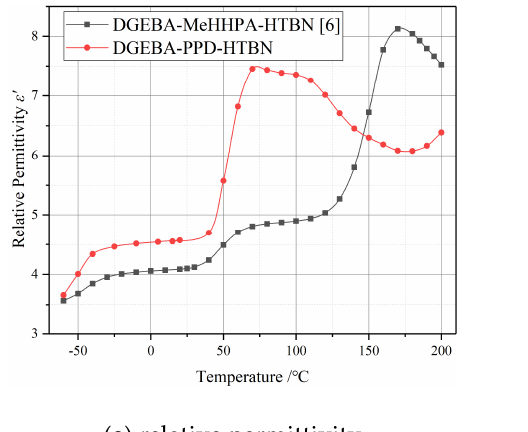
Figure 1. Temperature spectrum characteristics of epoxy resin with different hydroxyl-terminated liquid nitrile rubber (HTBN) contents at 50 Hz: ( a ) relative permittivity; ( b ) dielectric loss factor. Two different curing agents, methylhexahydrophthalic anhydride (MeHHPA) and polyoxide